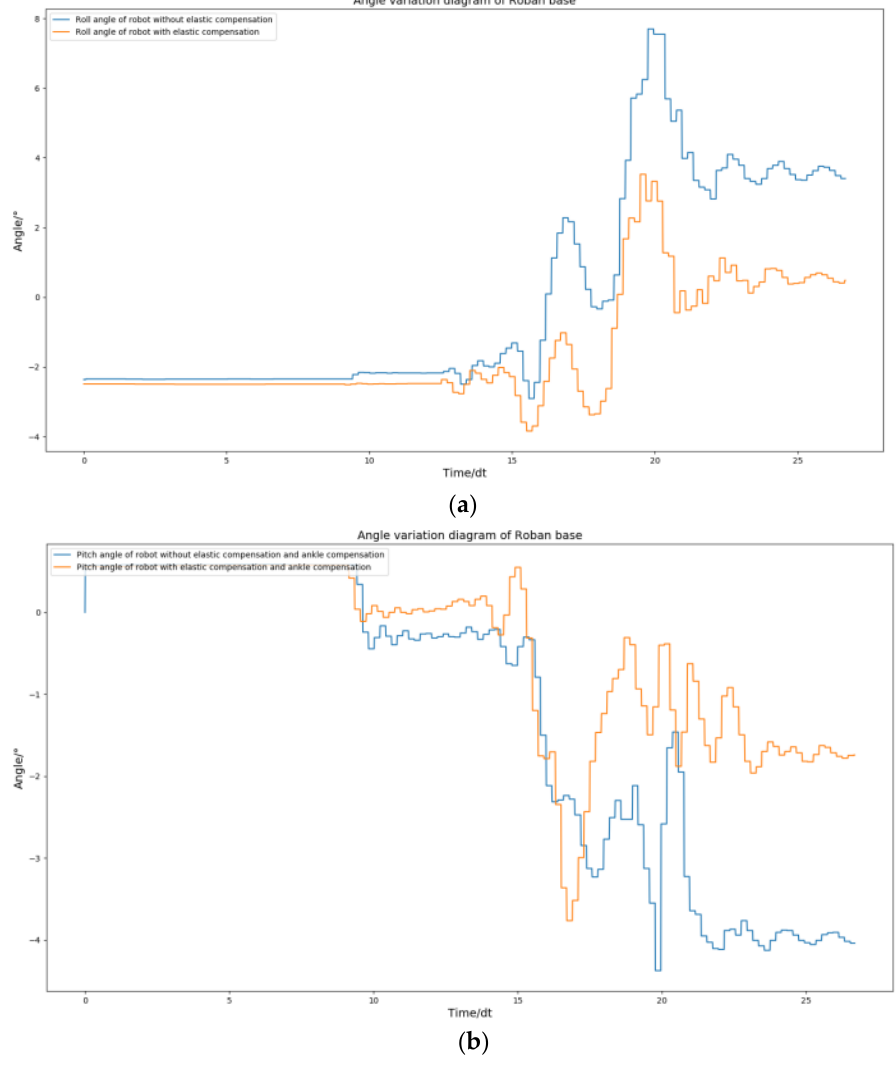
Figure 21. When Roban’s COM moves 5 cm, it competes three squats on a single leg at twice the speed. The comparison chart shows the roll angle and pitch angle with and without spring compensation. ( a ) Comparison diagram of roll angle change of robot with and without spring compensation. ( b ) Comparison diagram of pitch angle change of robot with and without spring compensation.